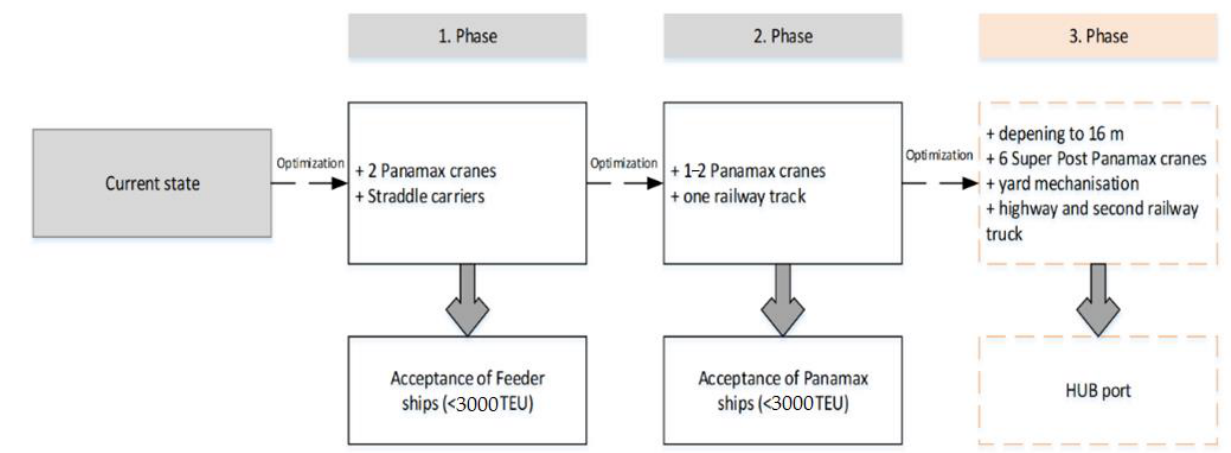
Figure 6. Optimization model result for the three scenarios.